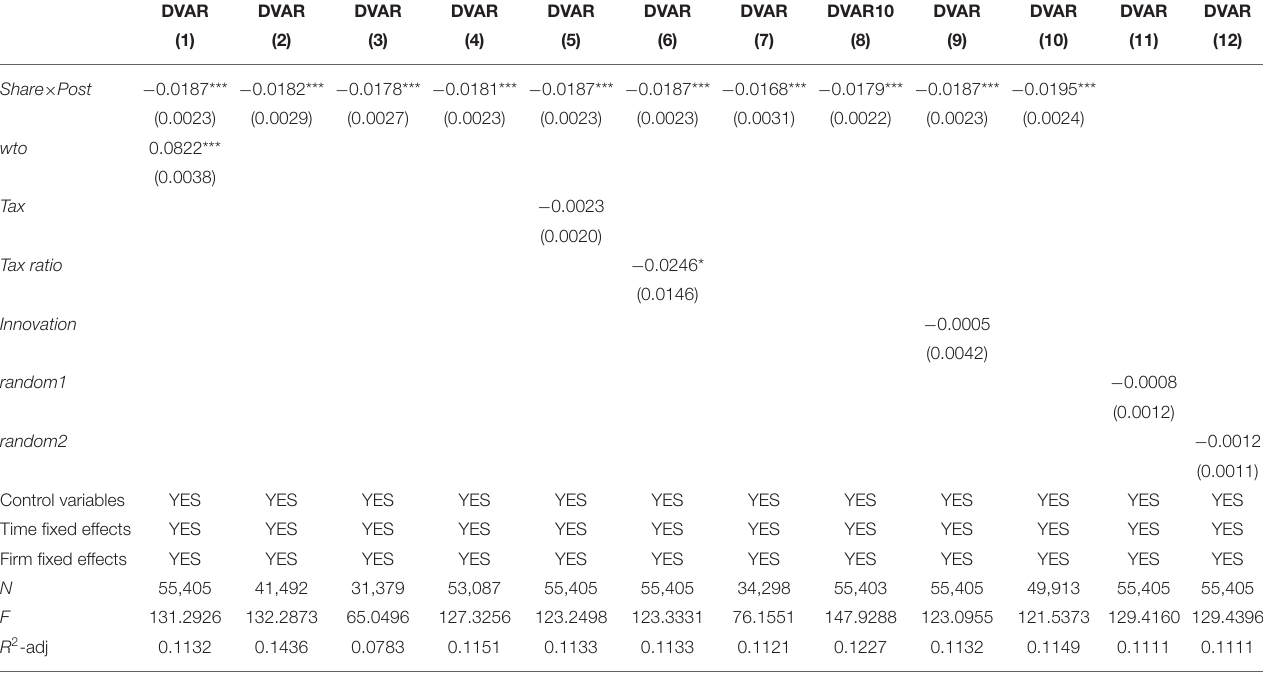
TABLE 3 | Robustness